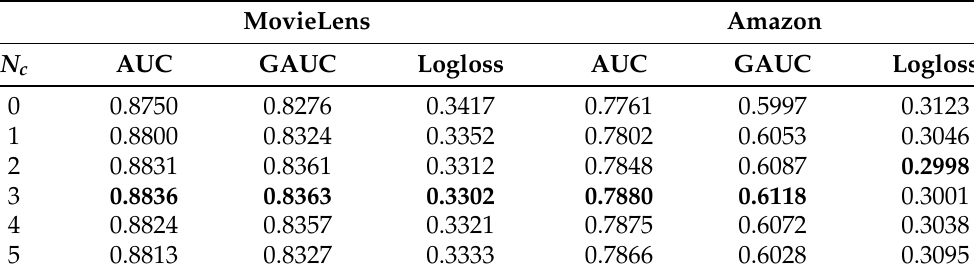
Table 6. Influence of parameter N c on the performance of CMBF. The results in bold represent the best performances.